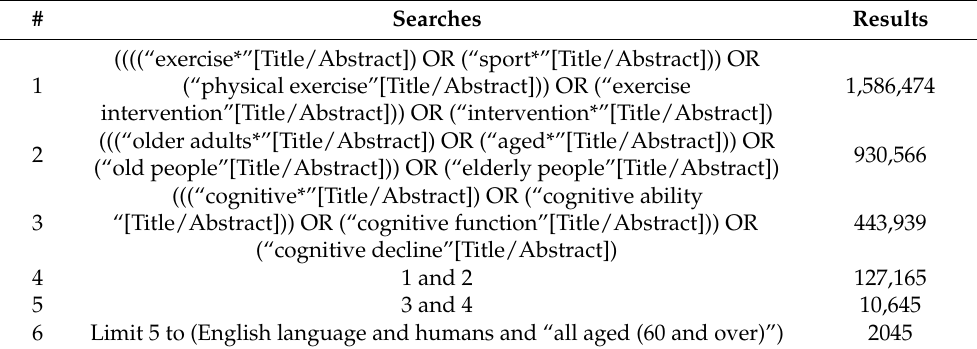
Table 1. Database search of